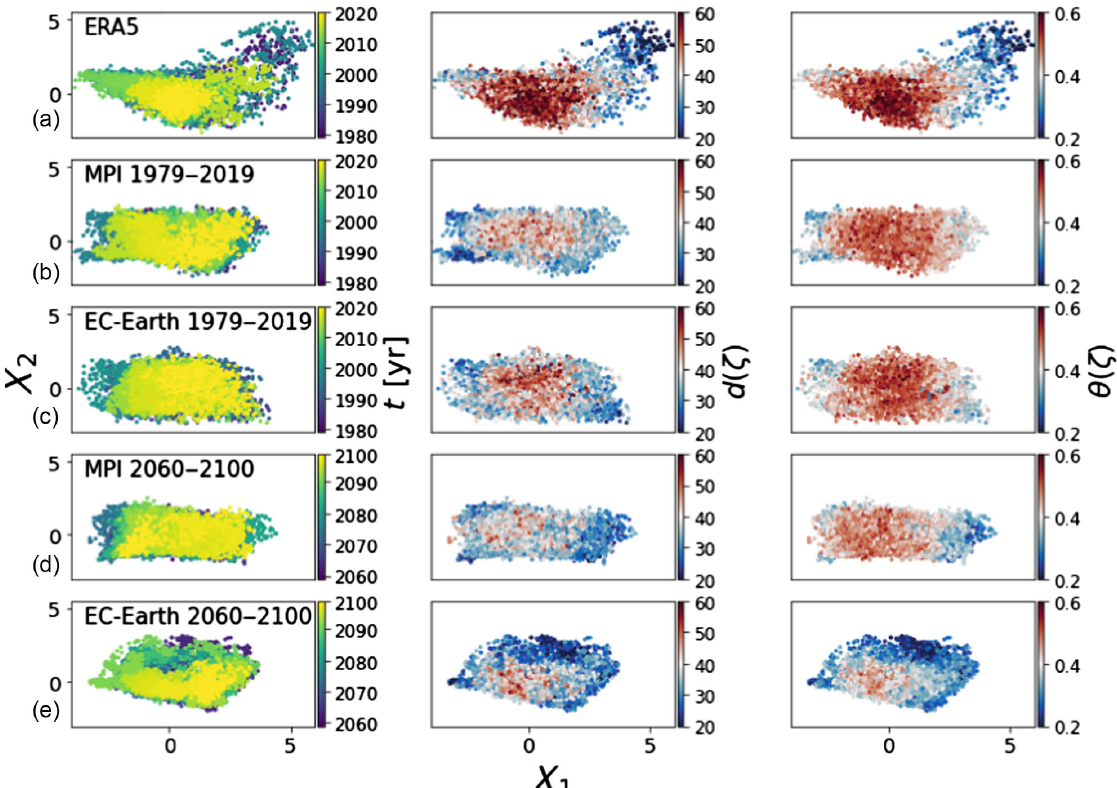
FIG. 7. In each row, from left to right: two-dimensional, Isomap projections of the high-dimensional state space dynamics; Isomap projections with each point colored by its local dimension d ð ζ Þ ; Isomap projections with each point colored by its local stability θ ð ζ Þ . (a) – (e) ERA5 reanalysis, MPI (1979 – 2019), EC-Earth (1979 – 2019), MPI (2060 – 2100), and EC-Earth (2060